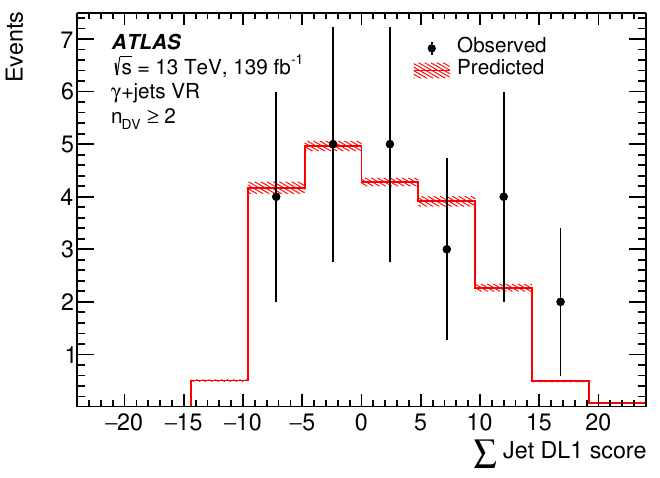
Figure 4 . The predicted (solid line) and observed (black points) numbers of background events with at least two DVs in the γ + jet VR as a function of the sum of the DL1 b -tag scores of the (up to) four leading jets. The shaded band represents the statistical uncertainty of the